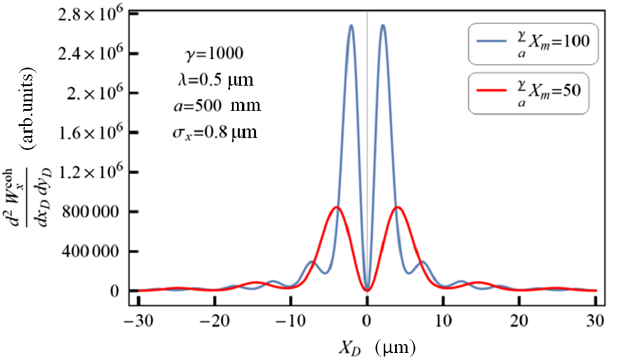
FIG. 9. Calculated COTR based beam profile image for a beam size of Σ x ¼ 0 . 8 μ m ( σ x ¼ 0 . 01 Þ and two different lens apertures. The parameter set used for the calculation is shown in the